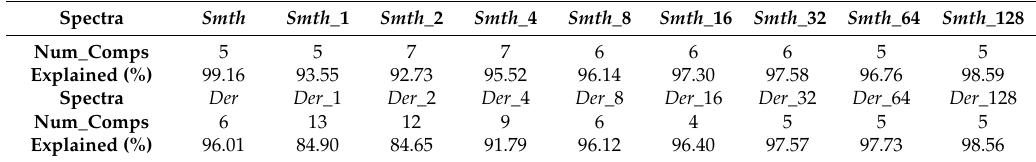
Table 2. Summary of percentages of total variance explained by the selected principal components.